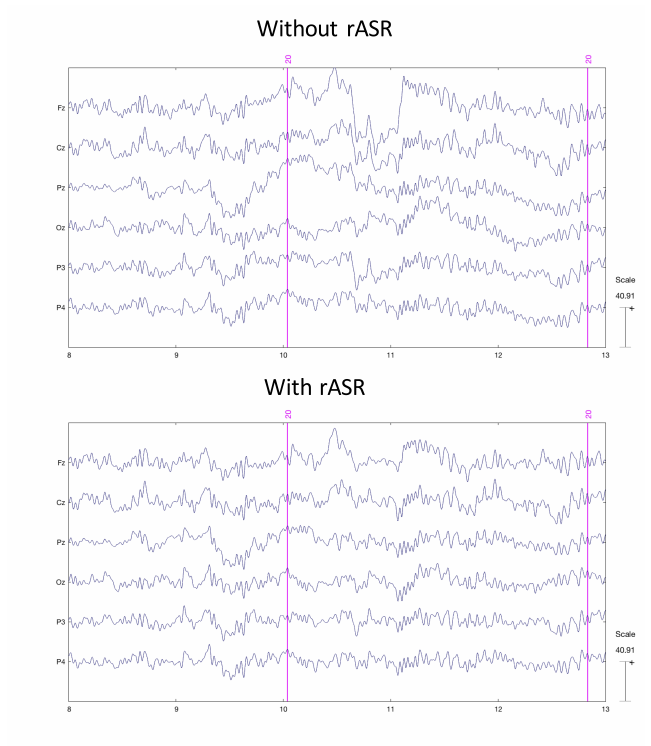
Figure 2. Up—Sample of EEG data before rASR processing for one subject. Sample of the same EEG data after rASR